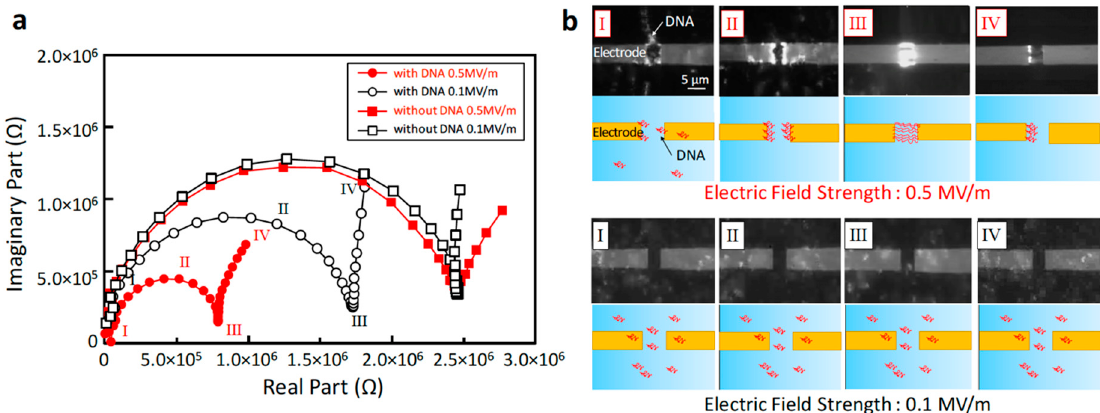
Figure 3. Typical electrical impedance responses and the corresponding motion and conformation of DNA. ( a ) Electrical impedance data for 10 kbp DNA (119 ng/mL) at the 3 µ m electrode gap in the form of Nyquist plots. ( b ) Images of the motion and conformation of DNA from Domains I to IV in the Nyquist plots. The upper images were obtained by fluorescence microscopy and the lower images show schematic illustrations.